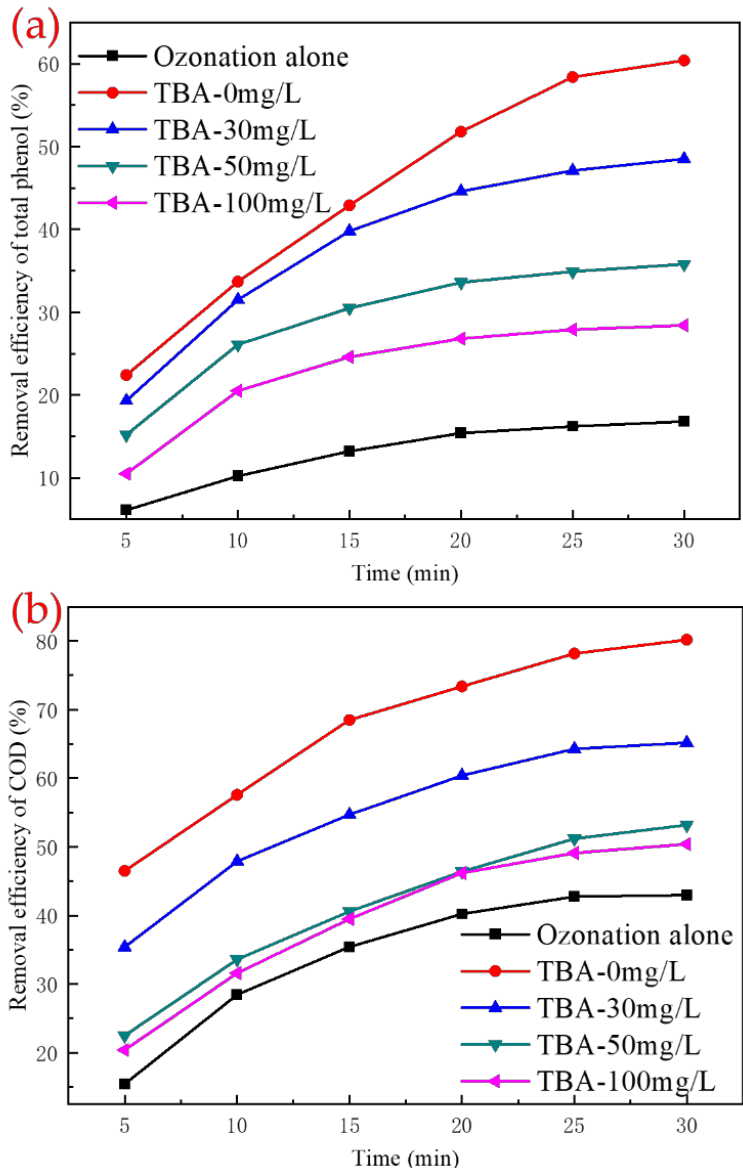
Figure 10. Effect of tert-butanol dosage on removal efficiency for ( a ) total phenol and ( b ) COD.